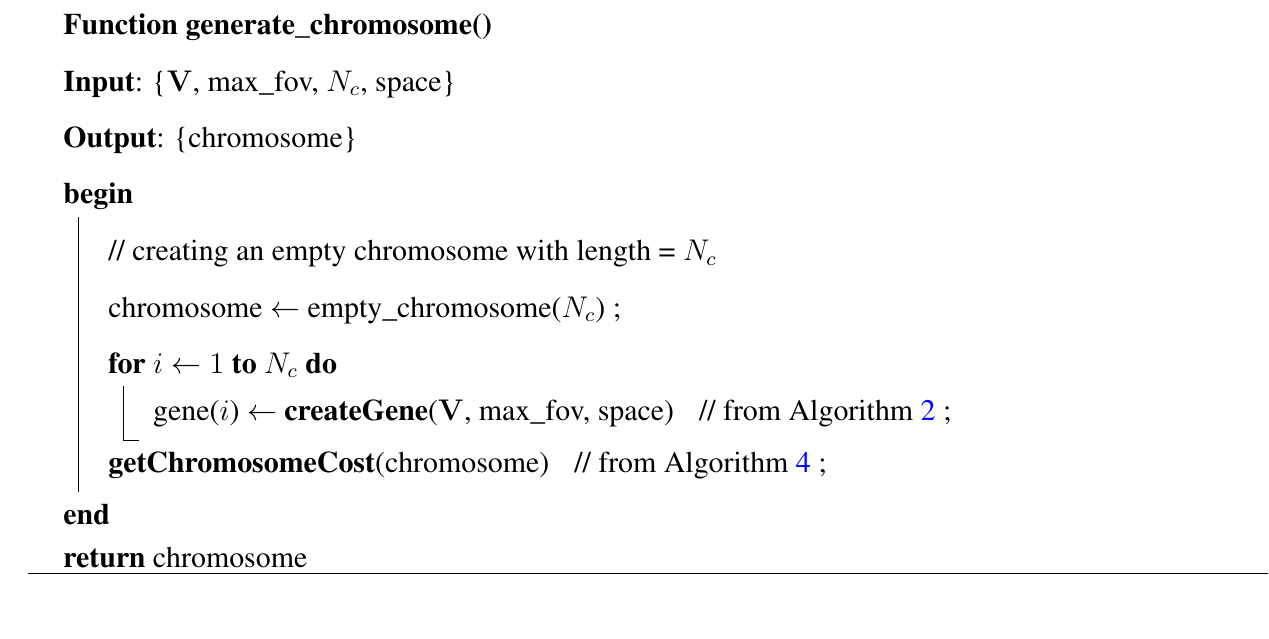
ALGORITHM 3 : Algorithm to generate a chromosome. V is the matrix of vertices of the polygon. N indicates the chromosome’s length or in other words the number of cameras. max_fov is the c maximum possible FOV for each gene (camera) and ‘space’ is the search space. Given these as inputs, the algorithm generate a chromosome with N